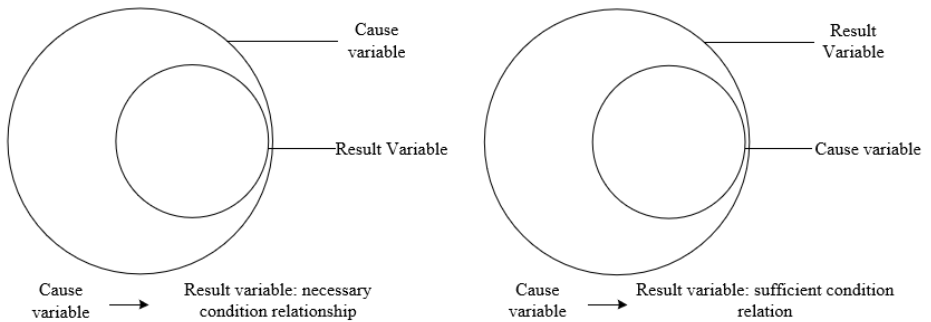
Figure 6. Relationship between cause and result variables.